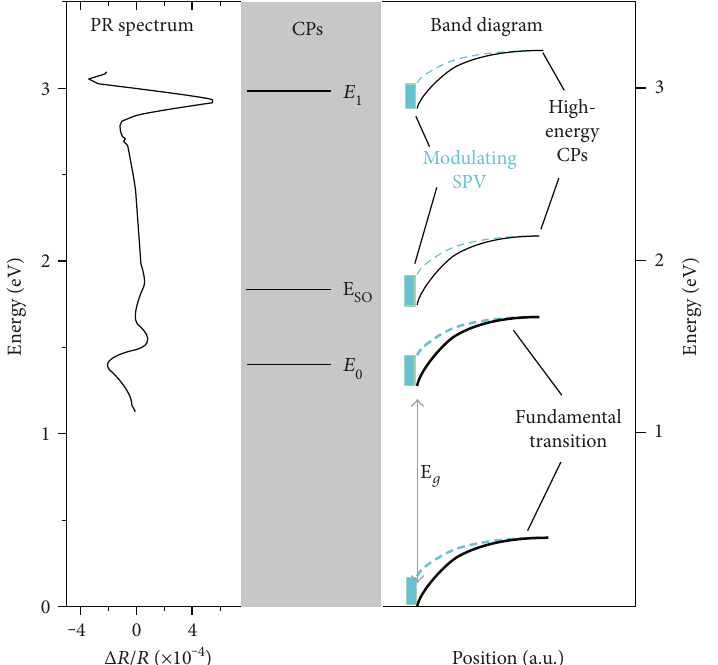
Figure 1: Schematic representation of critical points (CPs) E the same energy axis of a typical experimental PR spectrum (left). The band diagram picture (right) illustrates the modulation mechanism at CPs, namely, periodic SPV generation, upon illumination with a chopped pump beam of energy slightly above E fundamental gap. Notice that, although the E the corresponding energy is greater than the fundamental gap E